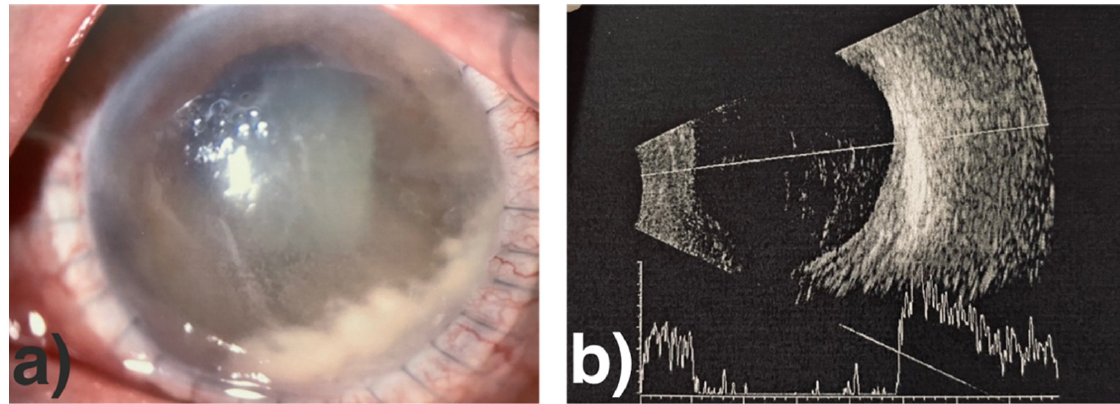
Figure 6. Biomicroscopic slit-lamp photography ( a ) and B-scan ( b ) of the left eye before enucleation with continuing progression in the anterior segment and beginning endophthalmitis.